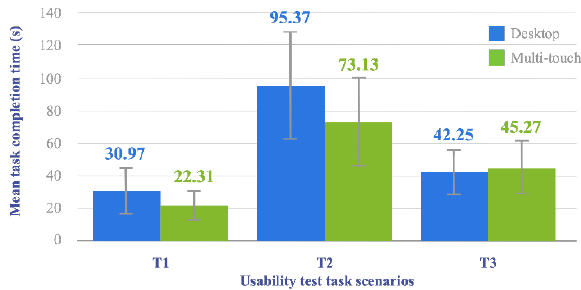
Figure 13. Mean completion time values for T1, T2 and T3 tasks performed both with Desktop and Multi-touch prototypes.